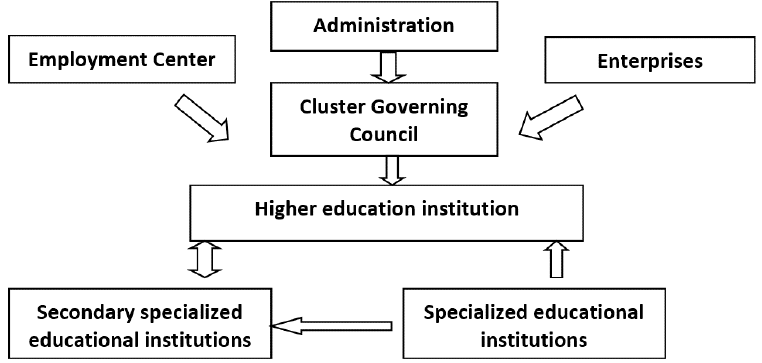
Fig. 1. Participants of the educational and production